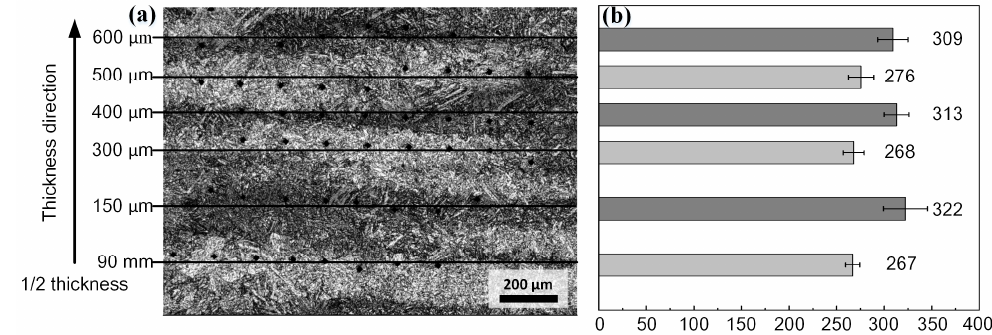
Figure 10. Microhardness comparison between alternate bands at t / 2. ( a ) OM of the segregation bands, ( b ) hardness of the segregation bands.